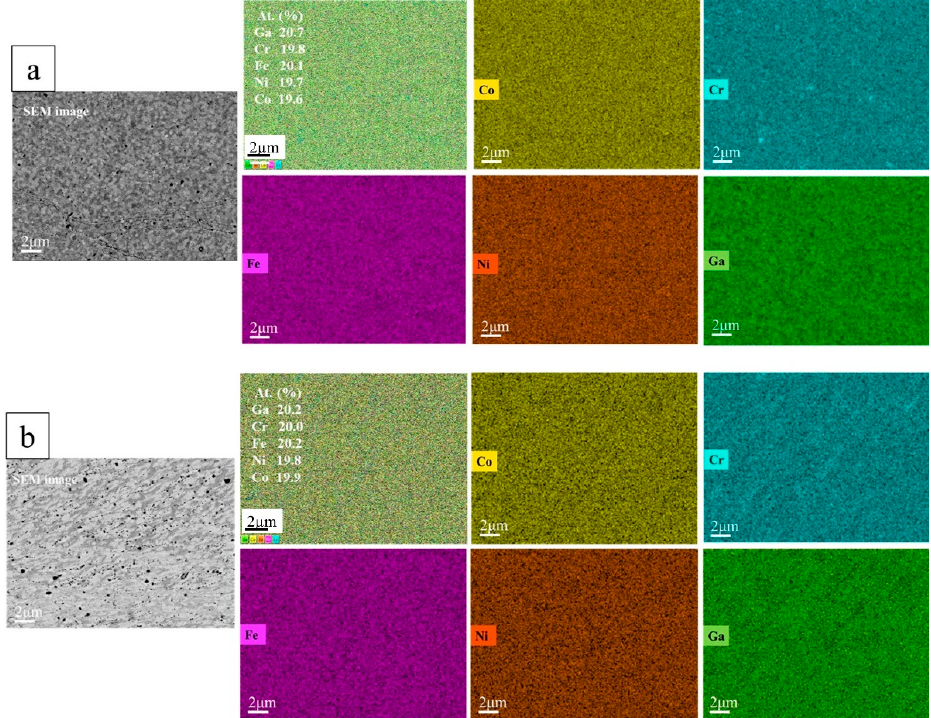
Figure 5. SEM images and EDX-mapping of the cross-section of bulk CoCrFeNiGa alloy ( a ) SPS- consolidated from HEA powder blend at 1073 K ( b ) after subsequent HPT treatment. Table 2. Crystallite size, lattice strain, and lattice parameters for bulk CoCrFeNiGa x (x = 0.5, 1.0) HEAs before and after HPT.